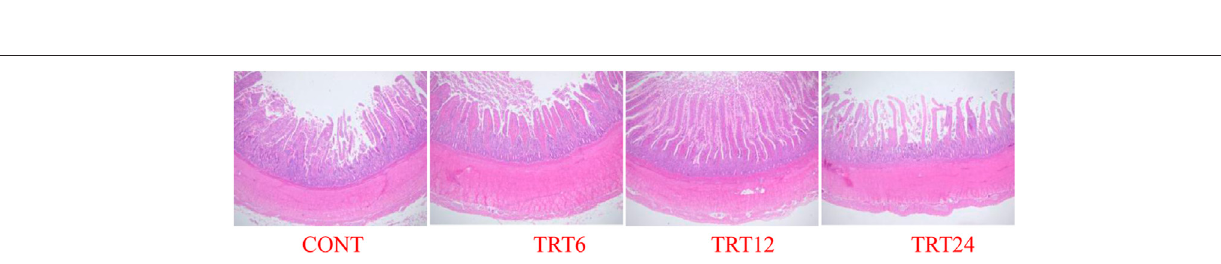
FIGURE 3 | Light micrograph of duodenum morphology in meat geese (40 × multiple). Control geese (CONT) were fed a basal diet, whereas TRT6, TRT12, and TRT24 were fed a basal diet supplemented with 6, 12, or 24% alfalfa-mixed silage fermented material, respectively.